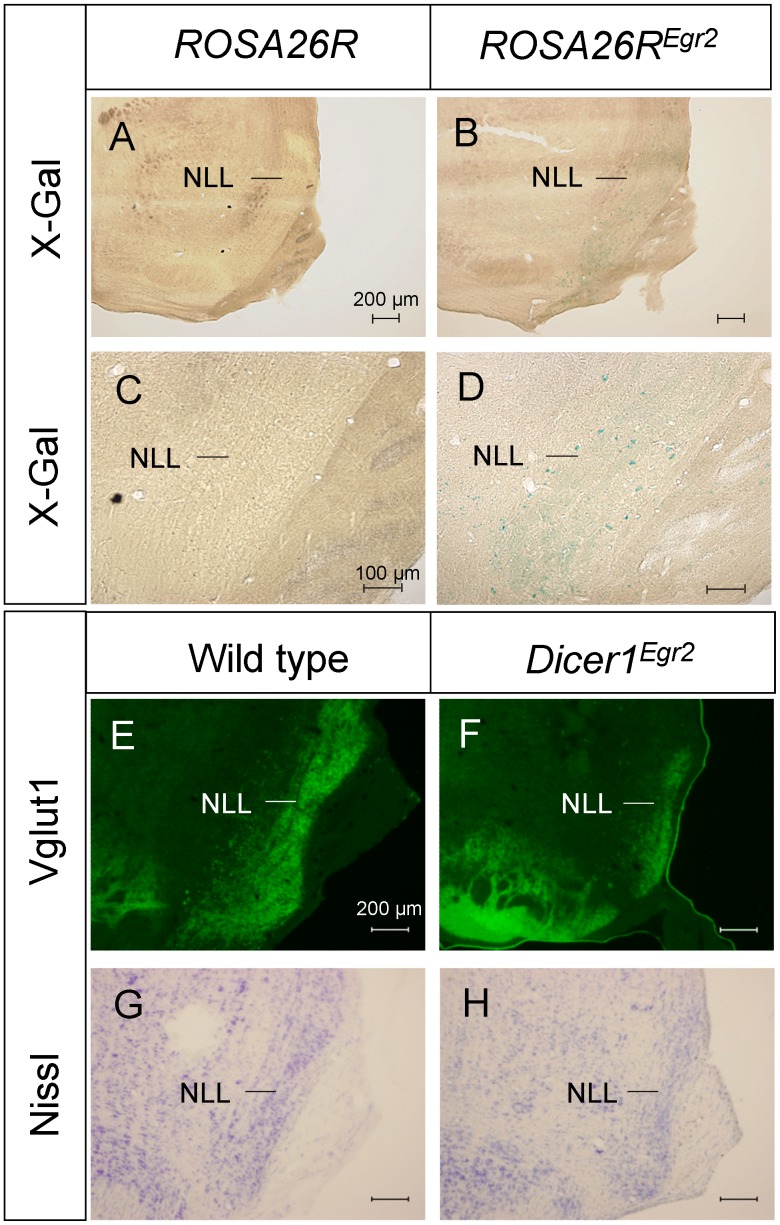
Reduced size of the nuclei of the lateral lemniscus is attributable to secondary effects of Dicer1 loss.
A–D, Egr2::Cre mice were crossed with ROSA26R mice, resulting in expression of β-galactosidase after Cre-mediated recombination. Only few X-gal positive cells were detected in the nuclei of the lateral lemniscus in the overview (A,B) or at high magnification (C,D). E,F, Vglut1 labeling of the nuclei of the lateral lemniscus in adult (P29, 2 animals per genotype) wild type (E) or Dicer1Egr2 mice (F) revealed reduced size of the nuclei in Dicer1Egr2 mice. G,H, Diminished size of the nuclei in Dicer1Egr2 mice (H) was confirmed by Nissl staining (P29, 2 animals per genotype) (G). NLL, nuclei of the lateral lemniscus. Dorsal is up, lateral is to the right.